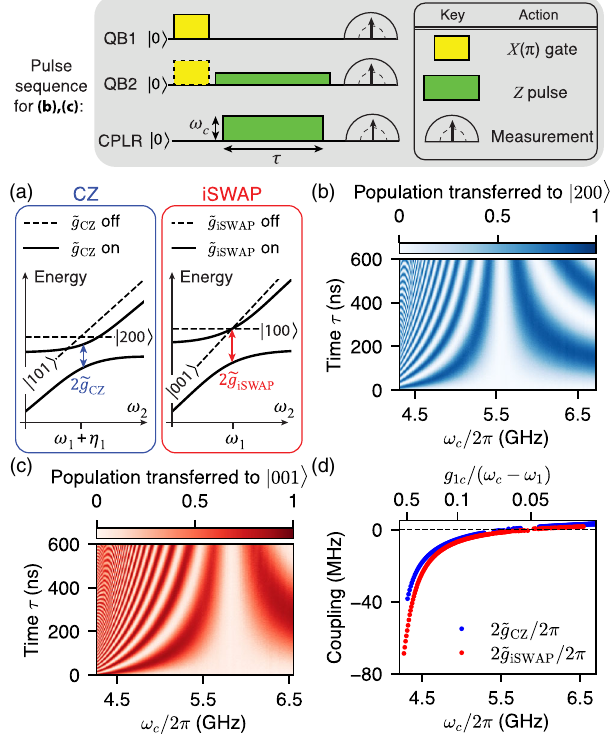
FIG. 2. The tunable coupling for the CZ and the iSWAP gates. (a) Illustrations of level crossings relevant to the CZ and the iSWAP gates. The energy splittings ( 2 ˜ g and 2 ˜ g ) are CZ iSWAP tunable by adjusting ω . See the main text for details. (b),(c) c Experimental data for the energy exchange between j 200 i and j 101 i , and j 100 i and j 001 i , as a function of the coupler frequency ω , respectively. The pulse sequences are illustrated at the c top. (d) By fitting the oscillations with sinusoidal curves, we = 2 π and j 2 ˜ g = 2 π (circles). The extract the swap rates j 2 ˜ g CZ j iSWAP j top x axis shows the corresponding perturbation parameter − ω ω g 1 = ð ω 1 Þ at each c c c